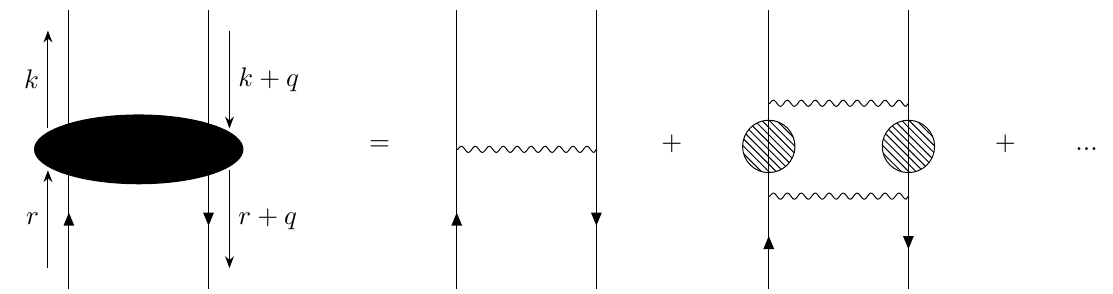
Figure 4. E(cid:11)ective four-fermion interaction.